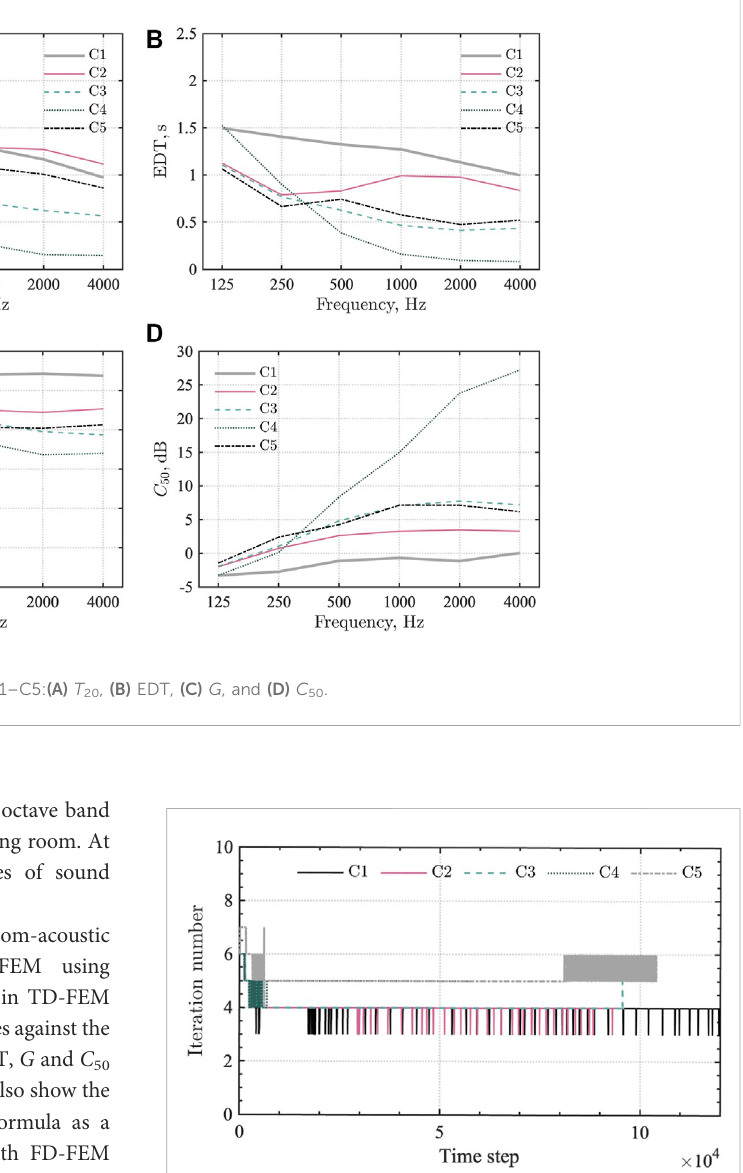
FIGURE 11 Comparison of iteration numbers among cases C1 –